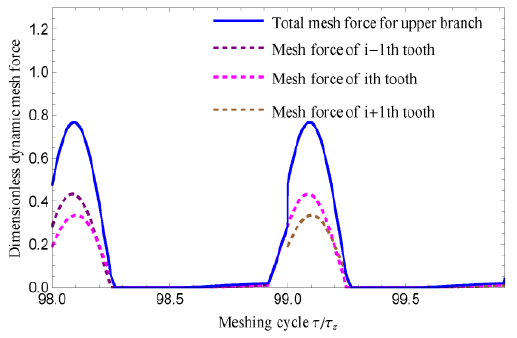
Figure 32. Dynamic mesh force for the upper branch when 𝜁̅ = 0.01 .